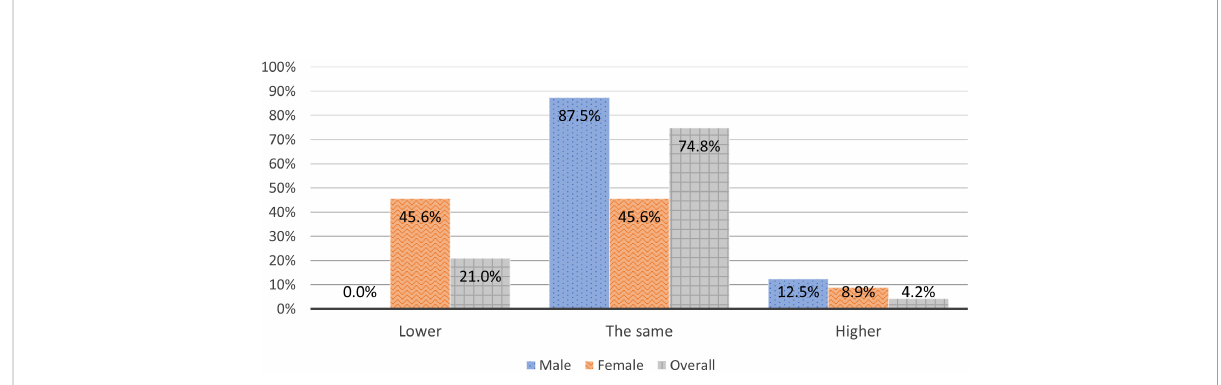
FIGURE 1 Is your achieved clinical position same, higher or lower in comparison to your opposite gender colleagues with the same experience and at approximately same